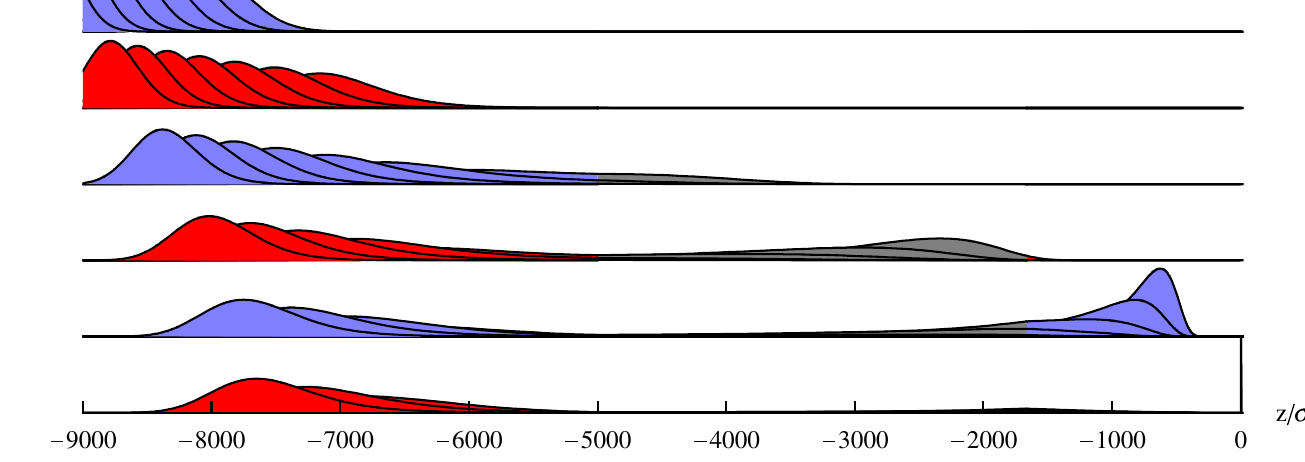
FIG. 11. (Color) Similar to Fig. 9, but with a 1 m drift (shaded in gray) between two magnets of curvature (cid:7) center of the bunch is 50 cm into the bend. A Gaussian bunch distribution is used with (cid:10) z ¼ 0 : 3 mm , an energy of 1 GeV, and a shielding height H ¼ 2 cm